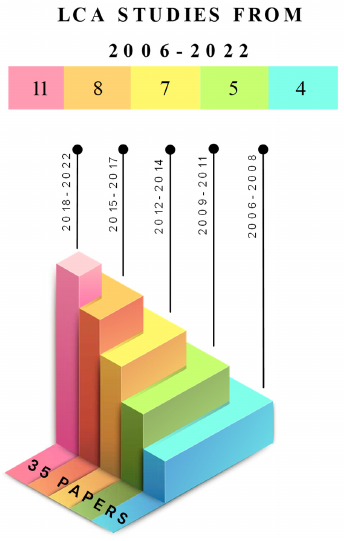
Figure 2. Number of LCA studies from 2006-2022.